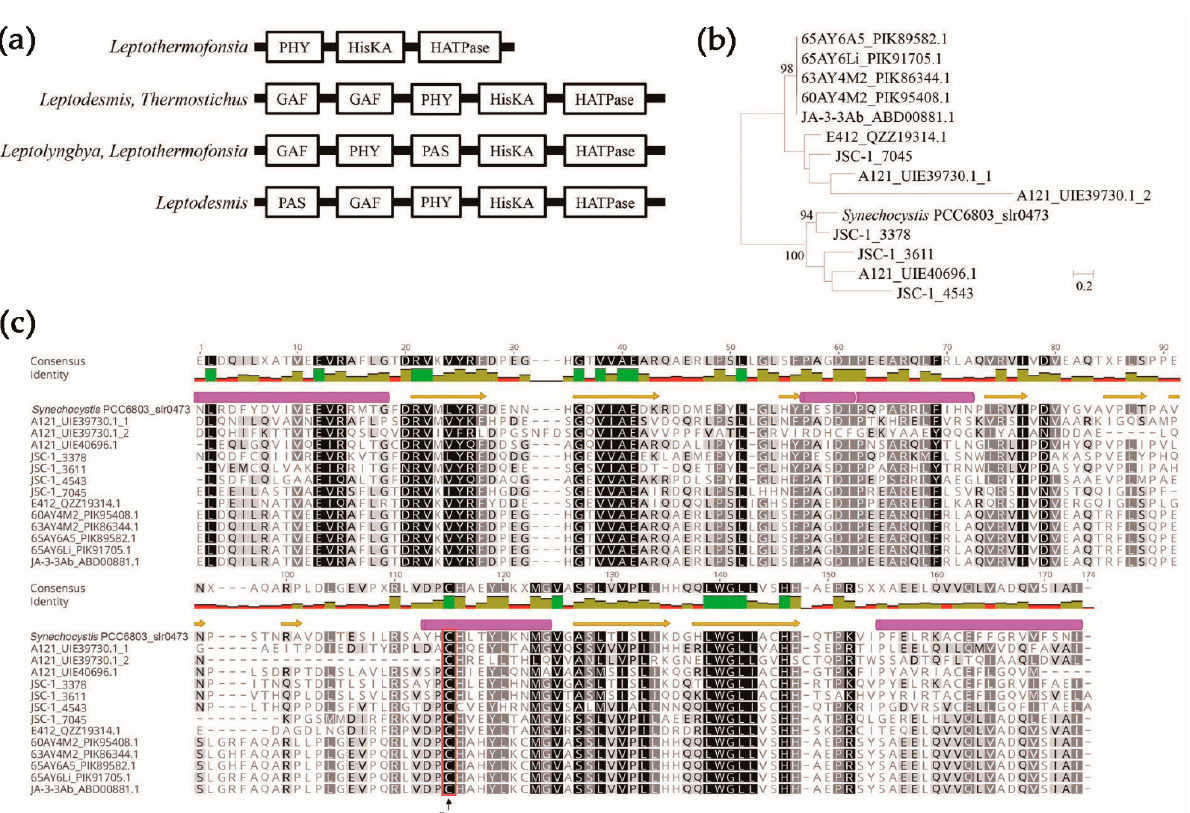
Figure 3. Molecular characterization of PHY-containing HKs. ( a ) Domain structure of PHY-containing HKs. ( b ) Phylogenetic inference of GAF domains within PHY-containing HKs. Scale bar = 20% substitutions per site. ( c ) Protein alignment of GAF domains within PHY-containing HKs. Chromophore-binding cysteine of Cys phytochromes were indicated by red box. The α -helix and β -sheet predicted were, respectively, indicated by cylinder and arrow.